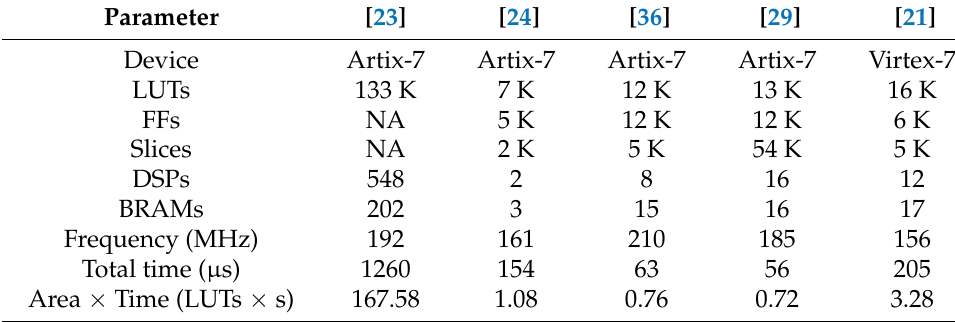
Table 7. Comparison of the state-of-the-art Kyber-1024 hardware architectures.